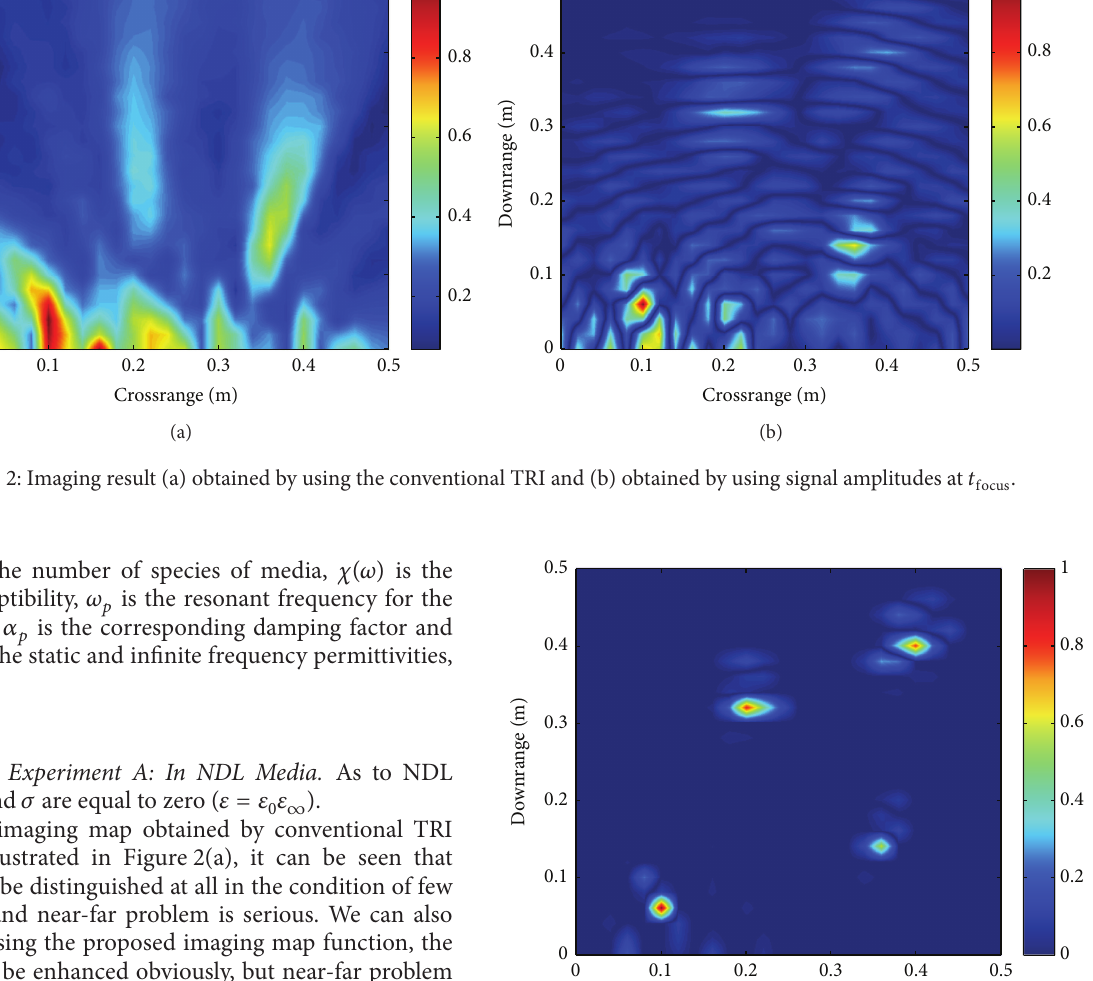
Figure 3: Imaging result obtained by using the proposed algorithm.